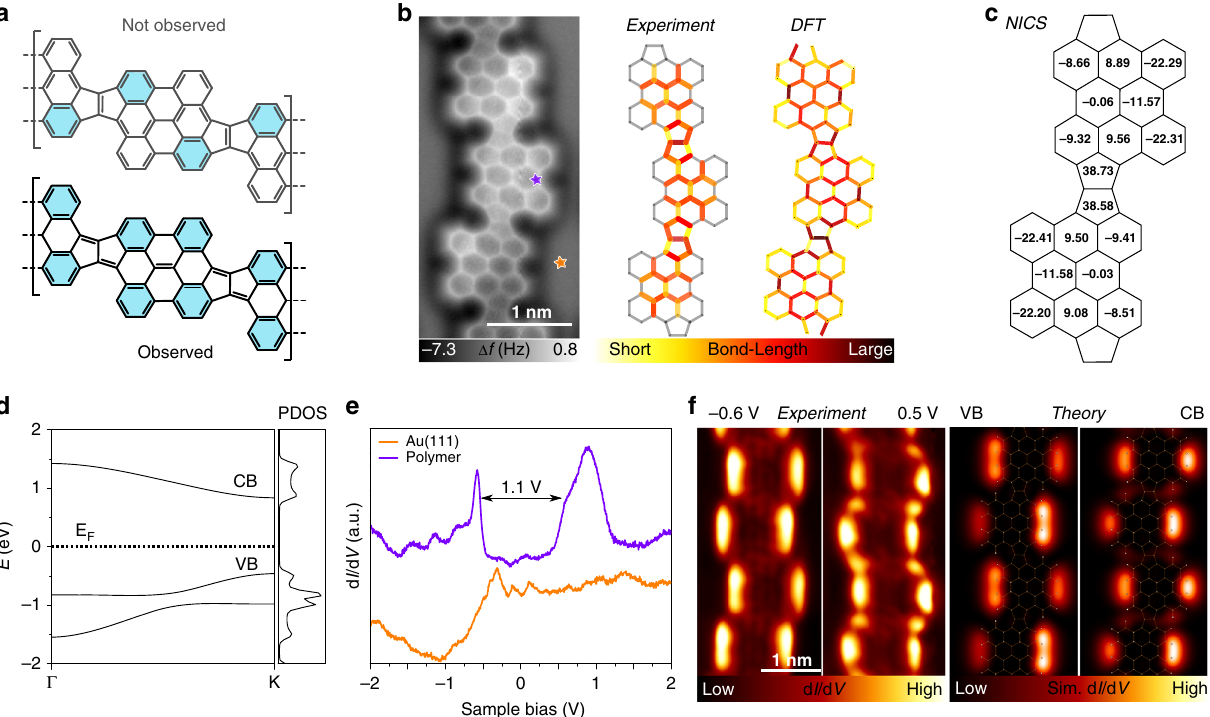
Fig. 3 Resonance and electronic structure of the pentalene-bridged bisanthene polymer (3). a Not observed and observed resonance forms of polymer 3 , featuring cis con fi guration. b High-resolution nc-AFM image of a section of the pentalene-bridged bisanthene polymer (left panel) and sketch illustrating the average bond lengths statistically measured from experimental nc-AFM images (central panel) and DFT calculation (right panel) of the bond lengths of a trans- section of the polymer. c NICS calculations of a pentalene-linked bisanthene dimer at distance of 1 Å above the center of each ring. d Calculated electronic structure of a freestanding cumulene-like bridged bisanthene polymer ( 3 ). e d I /d V scanning tunneling spectra acquired at selected site on polymer 3 and on Au(111) as indicated by stars in b . f Experimental and simulated d I /d V maps of the valence (VB) and conduction band (CB) of polymer 3